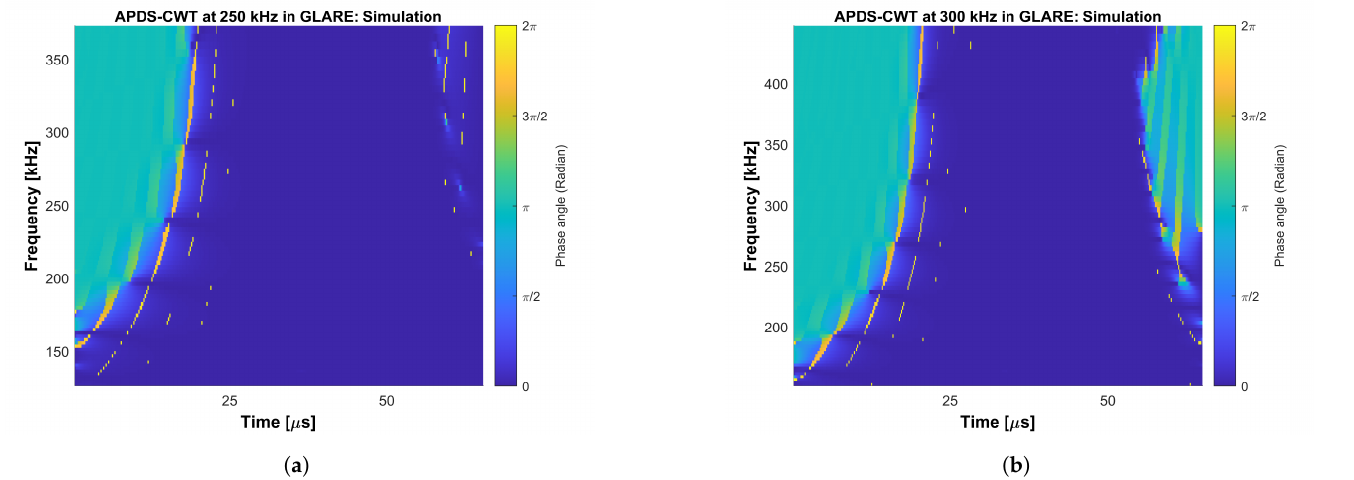
Figure A3. The APDS of the GLARE plate: the increase of the π -shifted area with increase of the time signal center frequency can be identified with an additional π -shift at 300kHz. ( a ) APDS-CWT of the GLARE plate at 250kHz. ( b ) APDS-CWT of the GLARE plate at